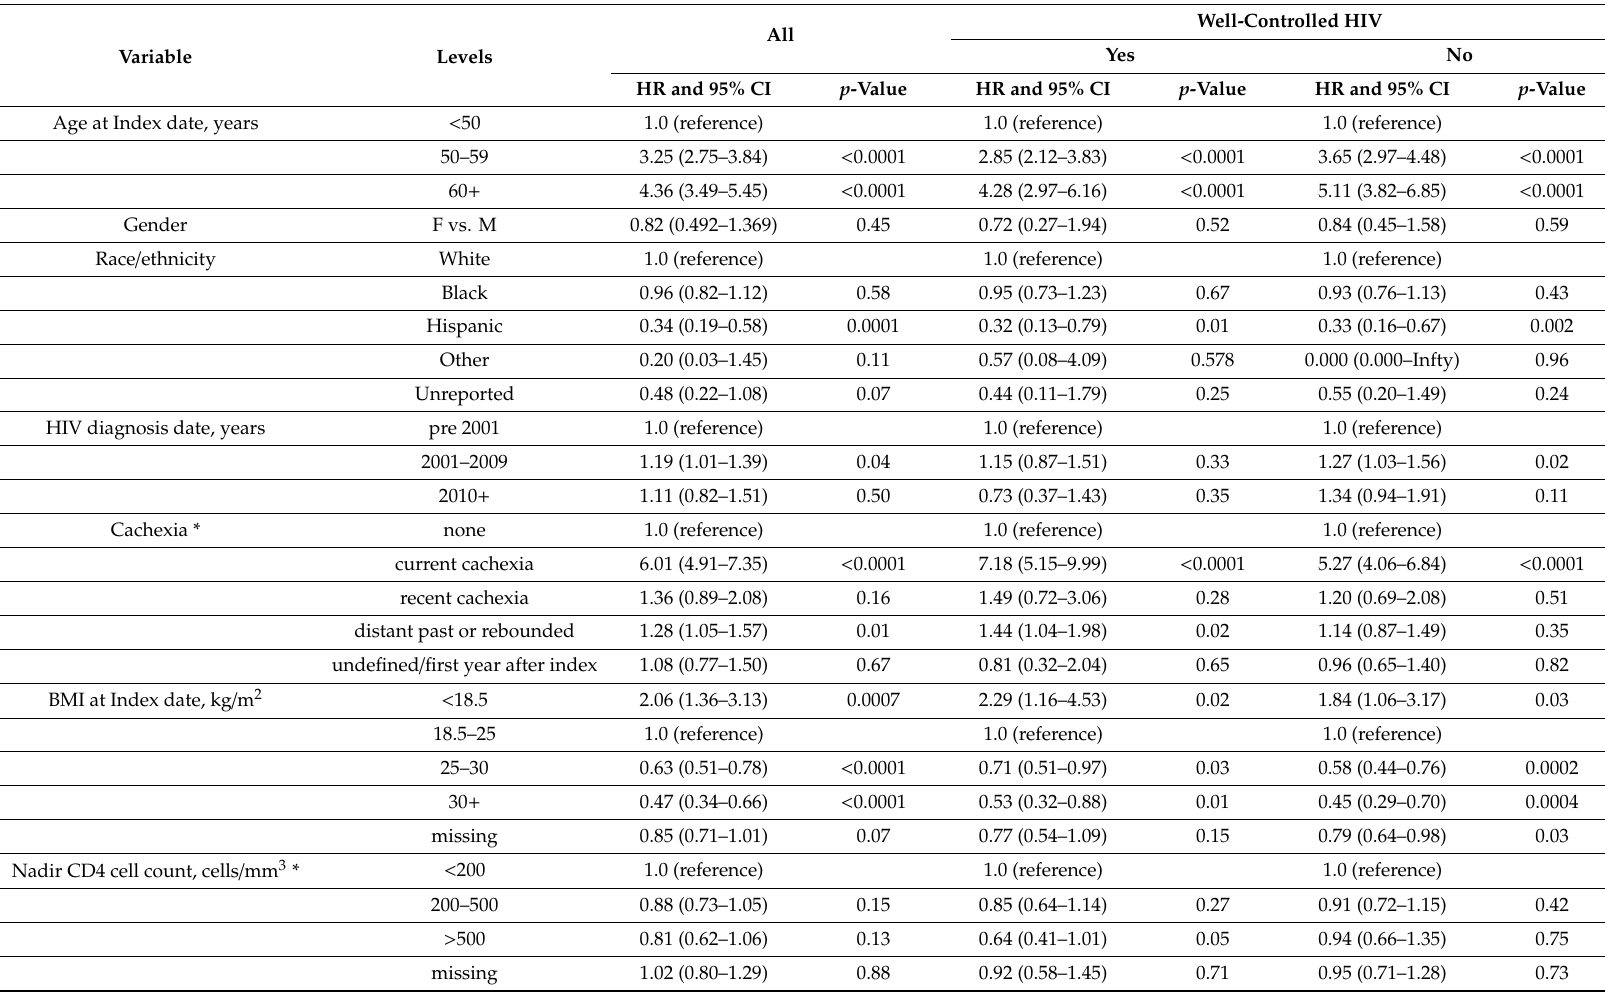
Table 2. Univariate Cox proportional hazard models for incident non-small cell lung cancer (NSCLC) risk in PWH with a history of smoking according to the degree of HIV viral